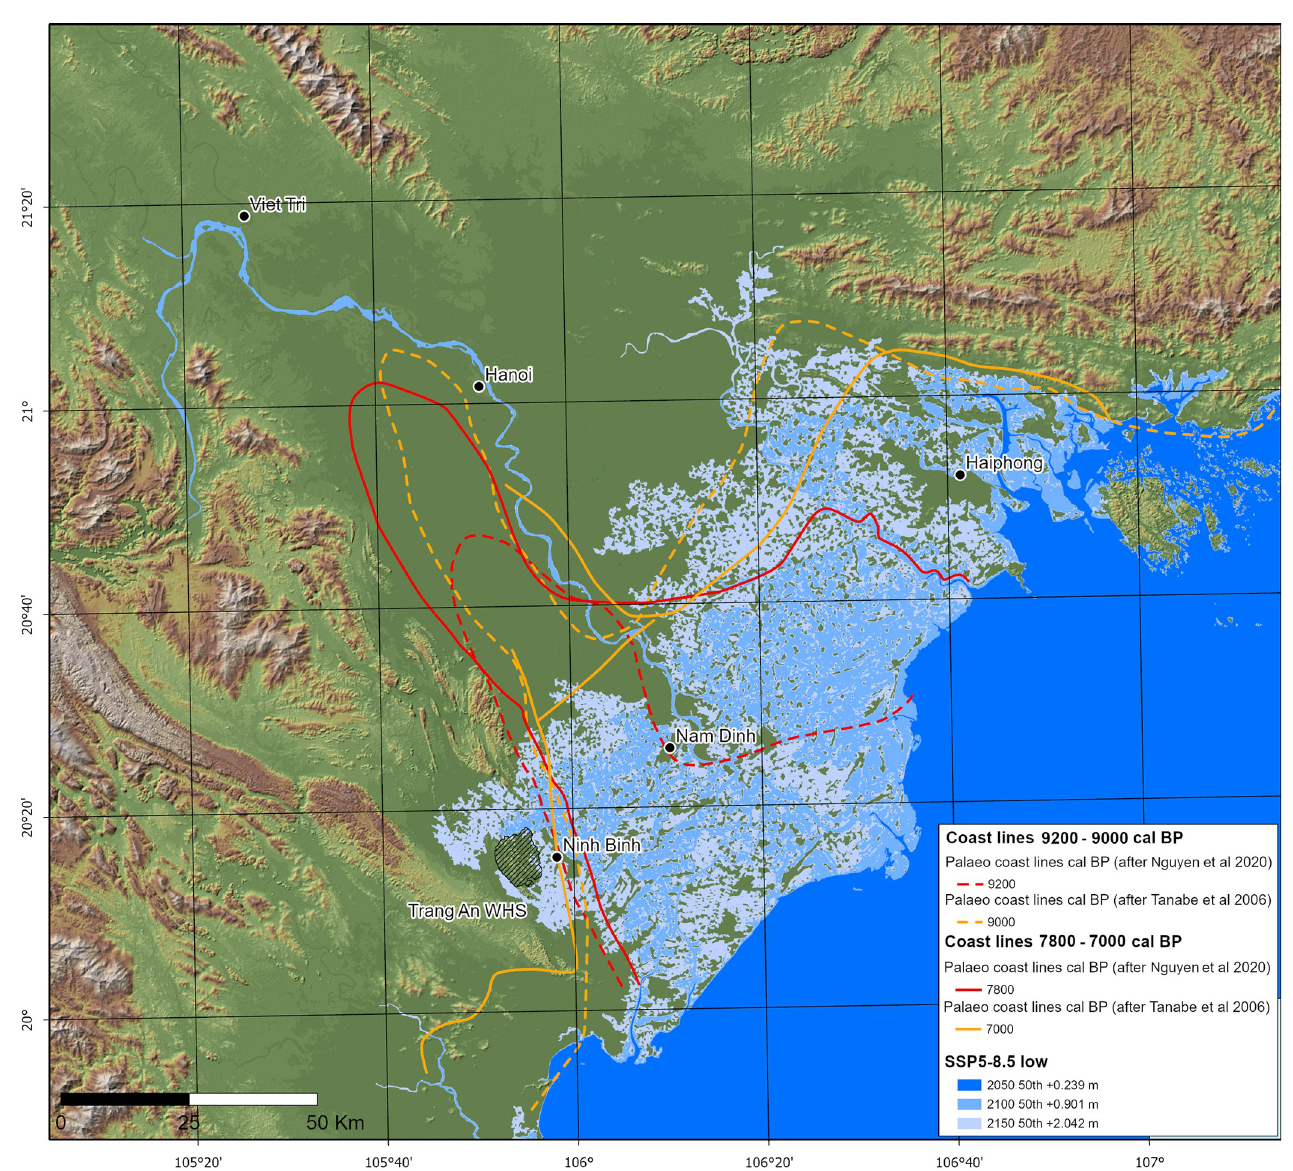
Fig 3. SSP5–8.5 (low confidence) sea level rise models for the years 2050, 2100 and 2150, contrasted with published early to Middle Holocene coastline models. The Tr à ng An Landscape Complex World Heritage Site is highlighted. All SSP models were generated by Thorsten Kahlert exclusively for this paper using Climate Central’s re-worked Shuttle Radar Topography Mapping Digital Surface Model (CoastalDEM 1 courtesy of Climate Central https://go. climatecentral.org/coastaldem/). Projected sea levels were obtained via the NASA IPCC AR6 Sea Level Projection Tool (https://sealevel.nasa.gov/data_tools/17) (Image: Thorsten